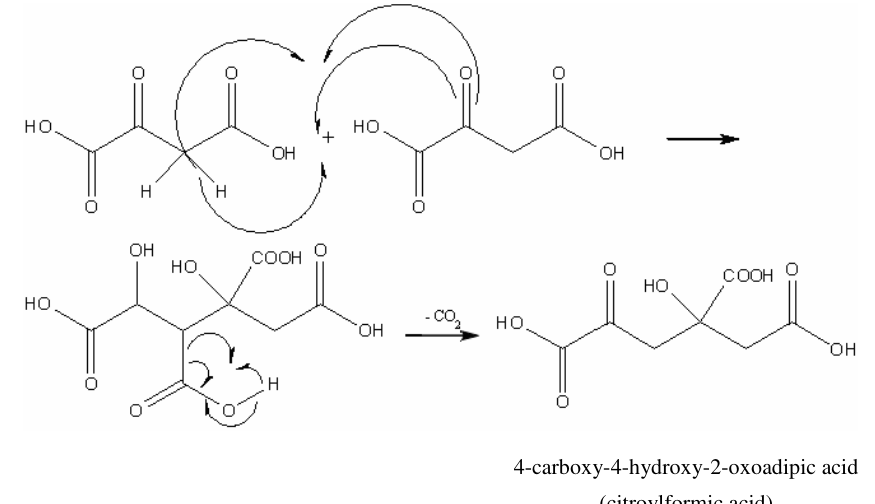
Fig. 4. Aldol reactions of oxosuccinic acid.